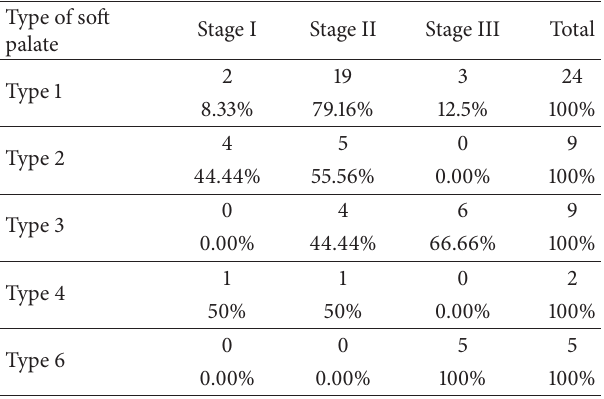
Table3:CrosstabulationfortypeofsoftpalateandstagingofOSMF. Type of